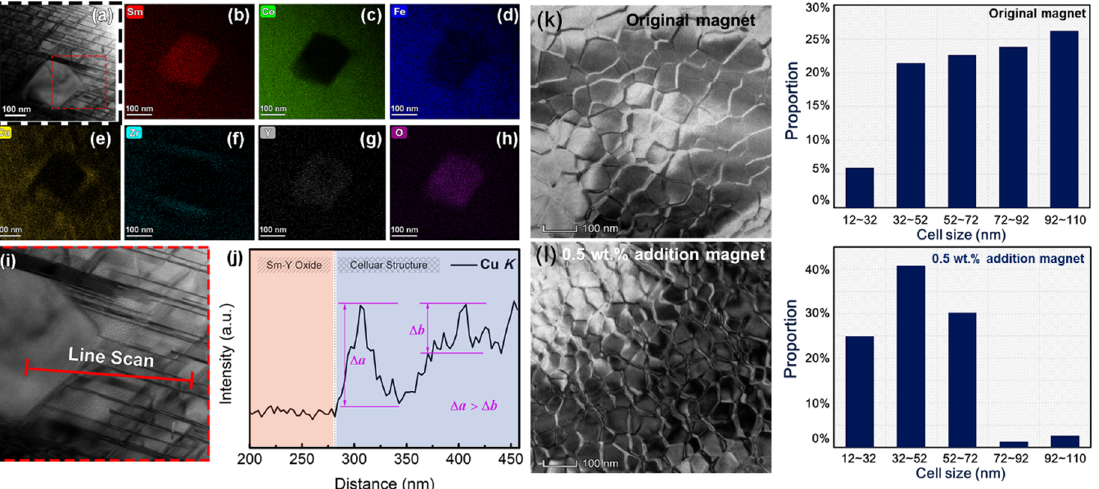
Figure 4. The TEM bright field image of 2:17R cell phase, 1:5 cell boundary phase and Zr-rich lamellar phase with an oxide inserted ( a ) and its EDS mapping ( b – h ), the magnified Cu-K line scan result ( j ) beginning from matrix phase and going across the oxide ( i ), TEM bright field image for the cellular structure perpendicular to the c-axis for the original magnet ( k ) and magnet with 0.5 wt.% addition ( l ), showing the corresponding cell size distribution for the original magnet and hybrid magnet.